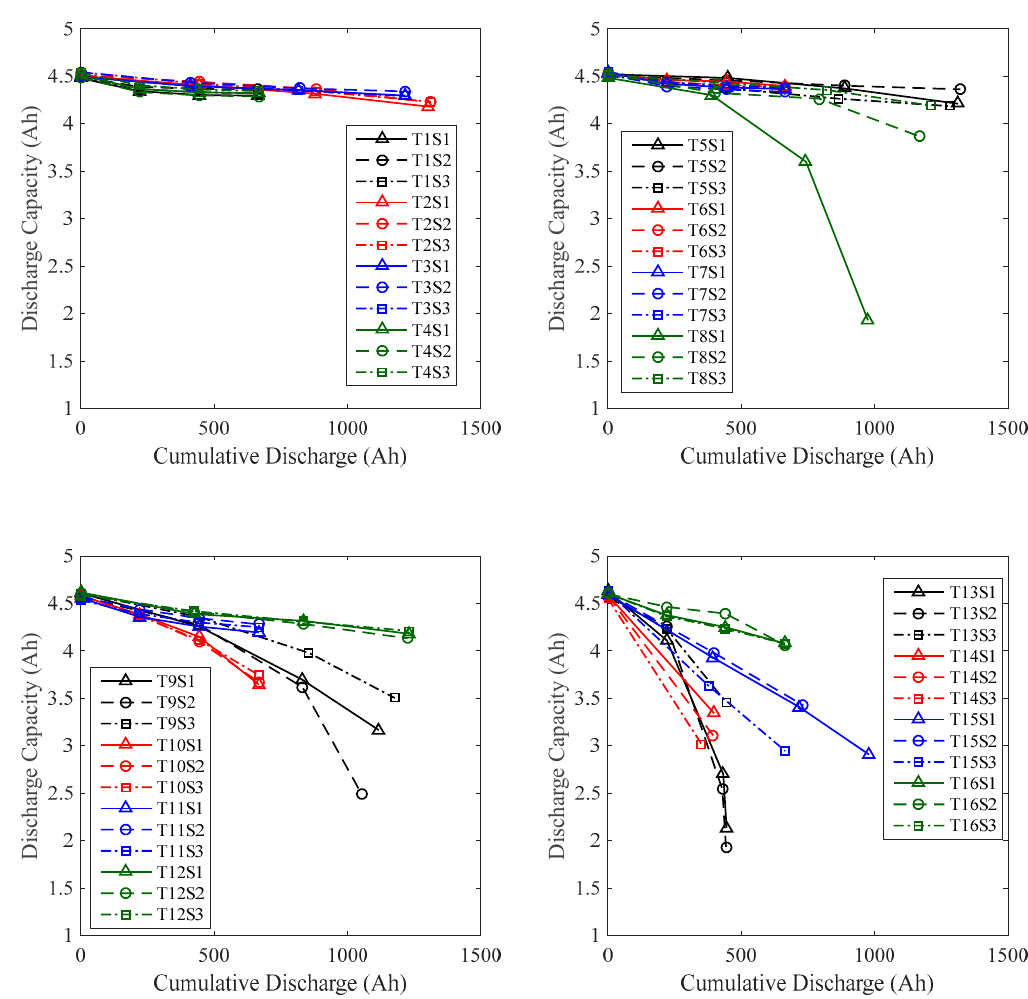
Figure 6. Variation of discharge capacity with cumulative discharge (Ah) for Manufacturer 2.